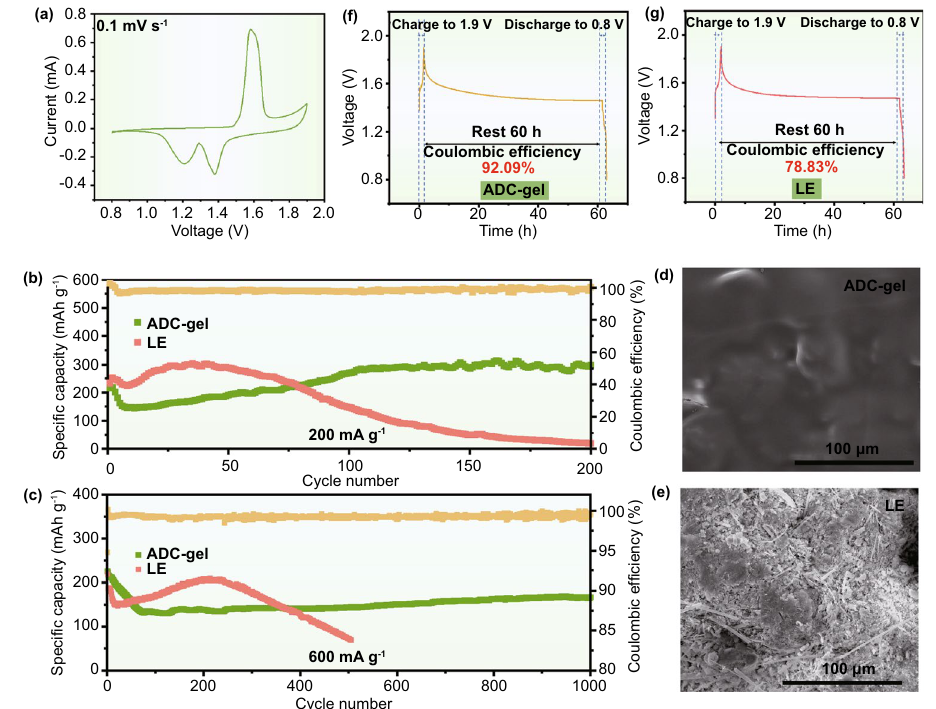
Fig. 6 a CV curve of Zn//MnO 2 battery with ADC-gel electrolyte. The cycling performances and the corresponding CE of ADC-gel and liquid electrolytes at a current density of b 200 mA g −1 and c 600 mA g −1 . SEM images of anode after cycles in d Zn/ADC-gel/MnO 2 and e Zn/LE/ MnO 2 batteries under the current density of 200 mA g −1 . The self-discharge tests performed on f ADC-gel electrolyte and g liquid electrolyte by fully charged after 10 cycles at 200 mA g −1 and then shelving for 60